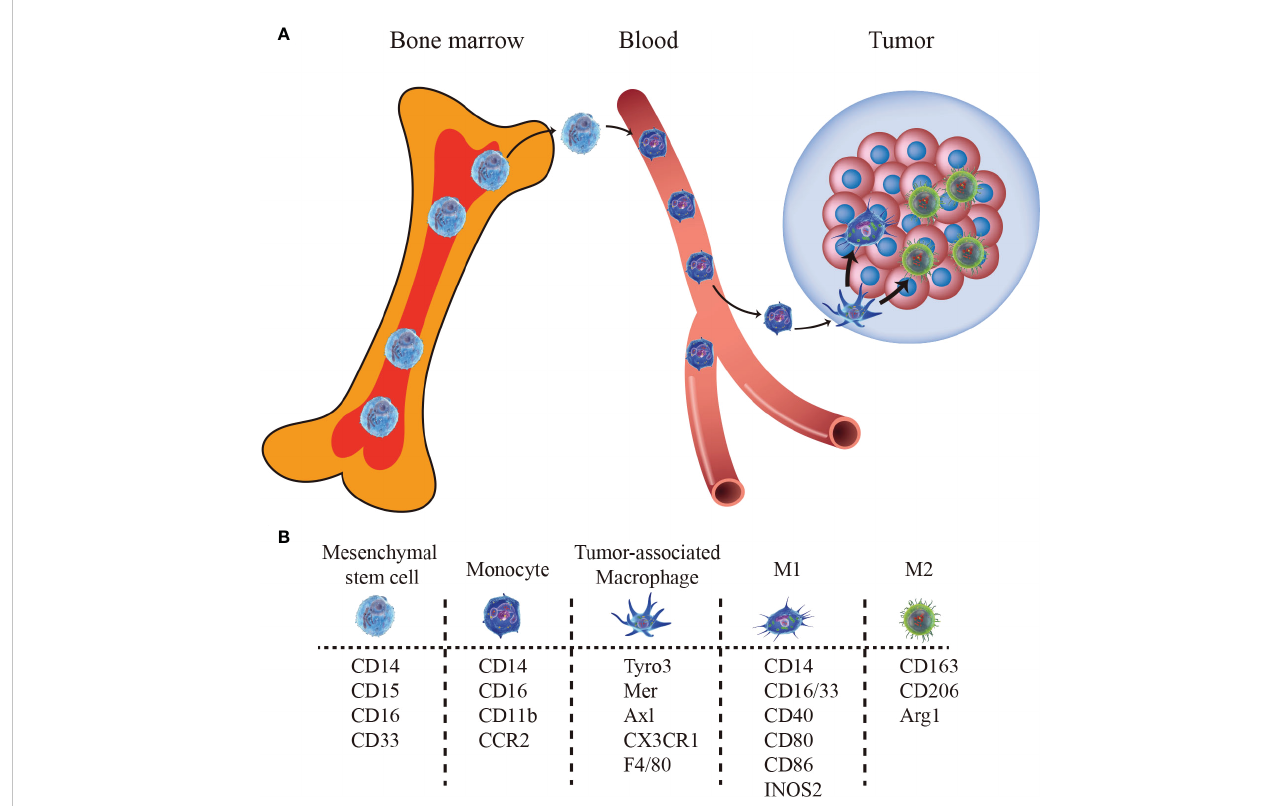
FIGURE 1 The bone marrow-derived macrophages pathway and biomarkers. (A) Monocytes egress from bone marrow and migrate to tumor sites, differentiating into TAMs. (B) Markers for mesenchymal stem cells, monocytes, TAM, M1-type TAM, and M2-type